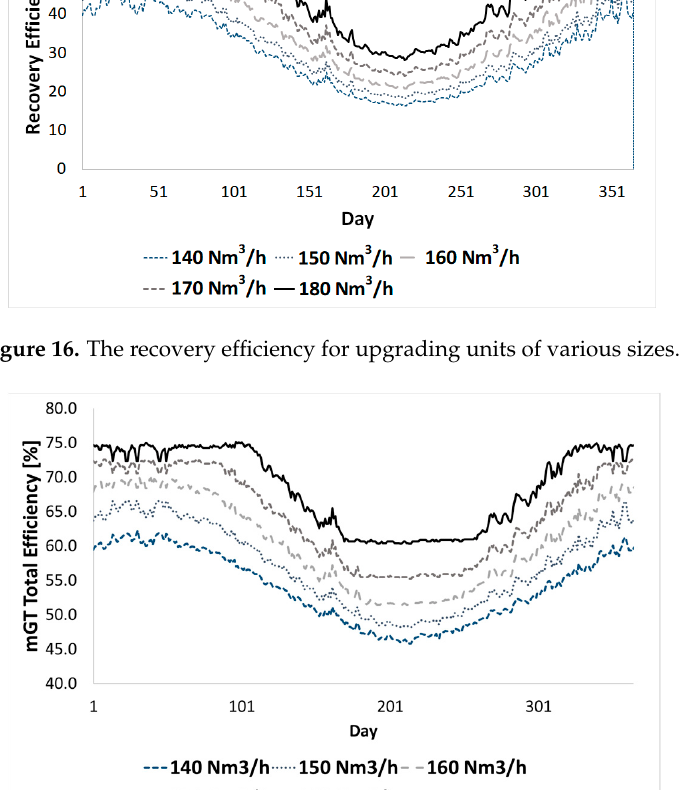
Figure 17. The total efficiency for various bio-methane productions.